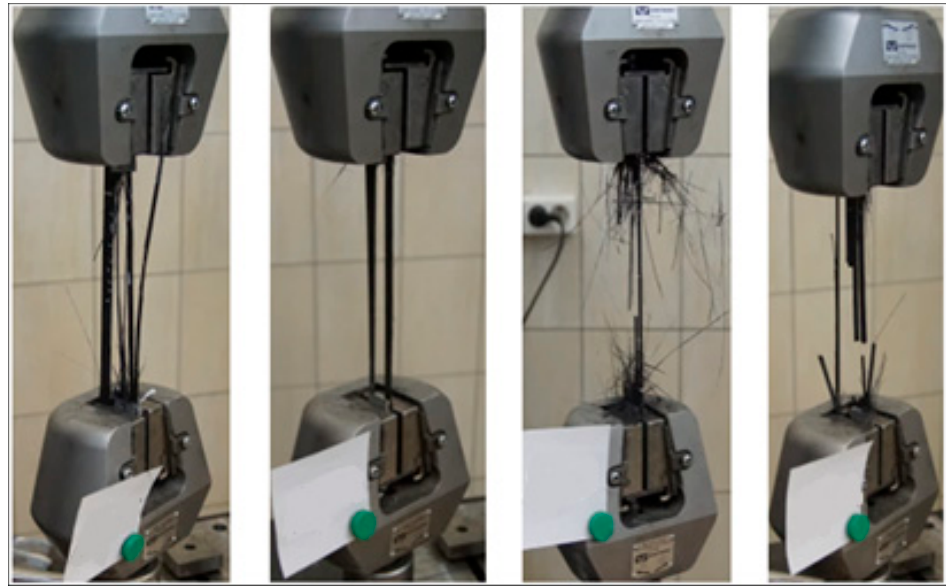
Figure 9. The failure of lamella specimens. Table 3. Results of tensile testing of CFPR specimens.